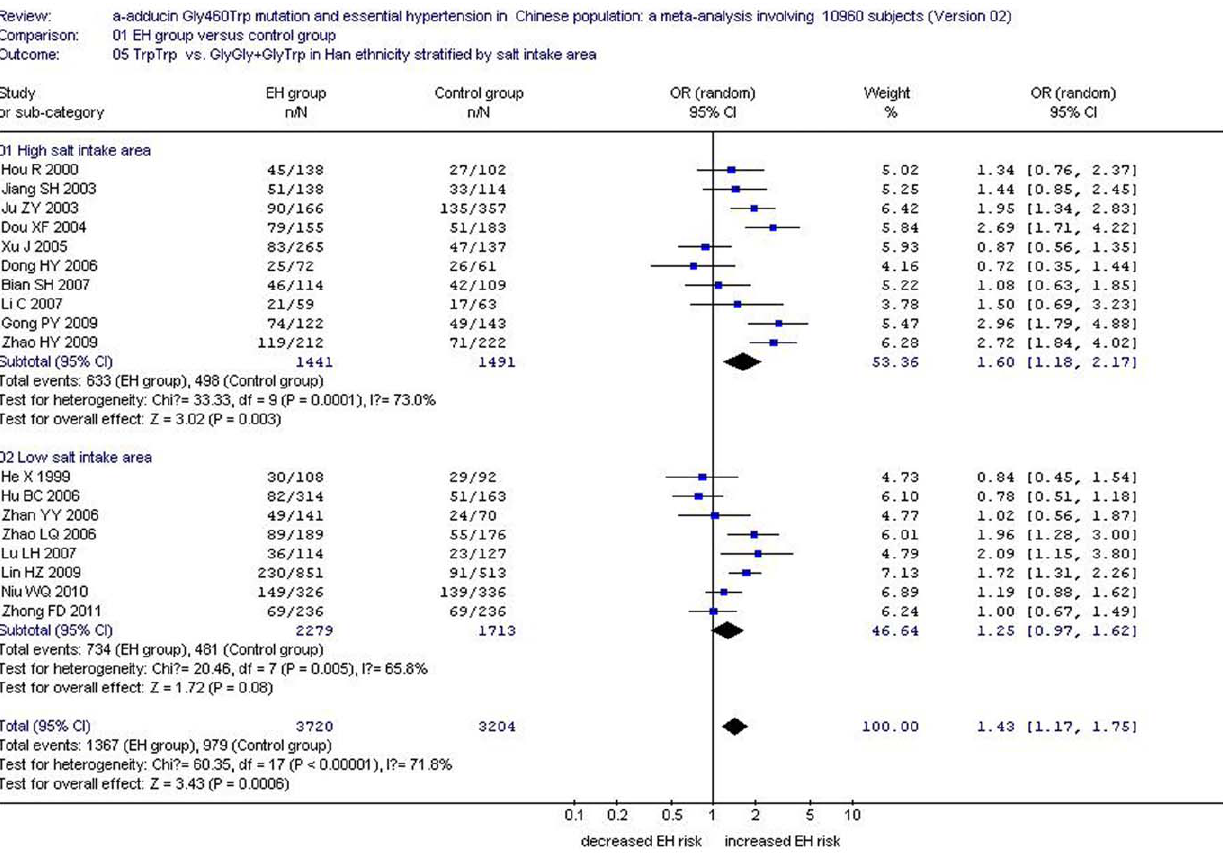
Figure 6. Forest plot of essential hypertension associated with a -adducin Gly460Trp gene polymorphism under a recessive genetic model (TrpTrp vs. GlyGly + GlyTrp) stratified by salt intake area in Chinese Han population.